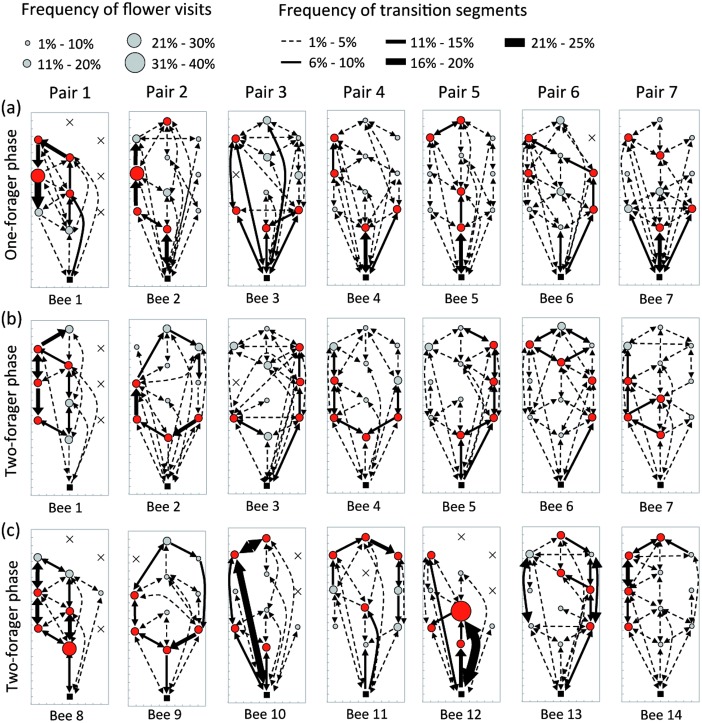
Flower visitation networks.Maps showing the cumulative movement patterns of (a) resident bees during the one-forager phase, (b) resident bees during the two-forager phase, and (c) newcomer bees during the two-forager phase. Visitation networks of bees from the same pair are presented in vertical columns. For each panel, we have represented the nest box (black square), the flowers that were visited at least once (circles), and the flowers that were never visited (grey crosses), by the focal bee. The diameter of each circle is proportional to the cumulative frequency of visits to that flower relative to the total number of visits to all flowers. The four flowers visited most frequently by the focal bee are shown in red. Arrows indicate the frequency and direction in which the bee moved between pairs of locations. Arrow thickness is proportional to the cumulative frequency of transitions between locations relative to the total number of transitions observed. Single-headed arrows indicate the bee was significantly more likely to move in one direction during that transition (binomial test with probability 0.5 to move in either direction, P < 0.05). Two-headed arrows indicate symmetrical transition direction. Labels (Bee 1–14, Pair 1–7) refer to the same individuals throughout the study.